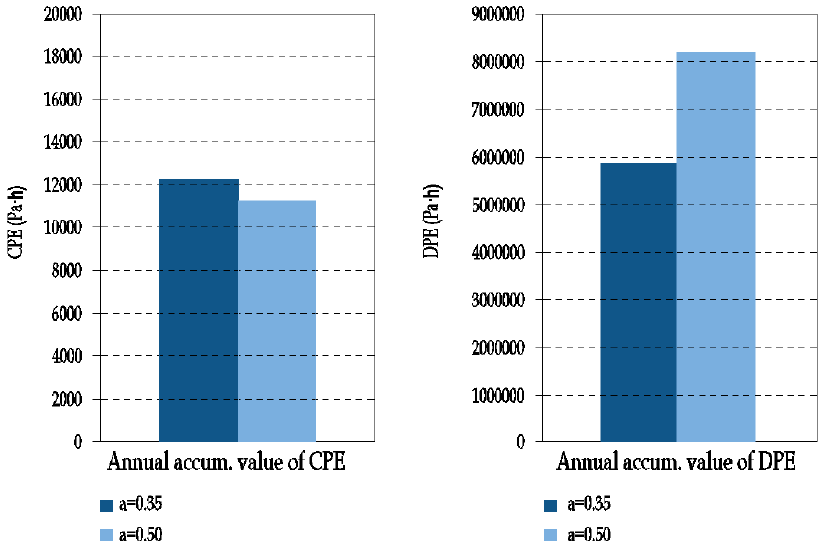
Figure 7. Properties of the exterior layer: absorbance to solar radiation (author’s archives based on [8]).